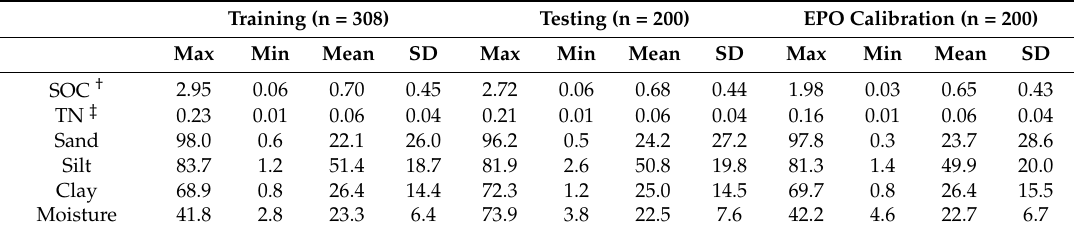
Table 2. Maximum, minimum, mean, and standard deviation (SD) of laboratory-determined soil properties for the training, testing, and external parameter orthogonalization (EPO) calibration datasets. All units are in % (g × 100 g soil − 1